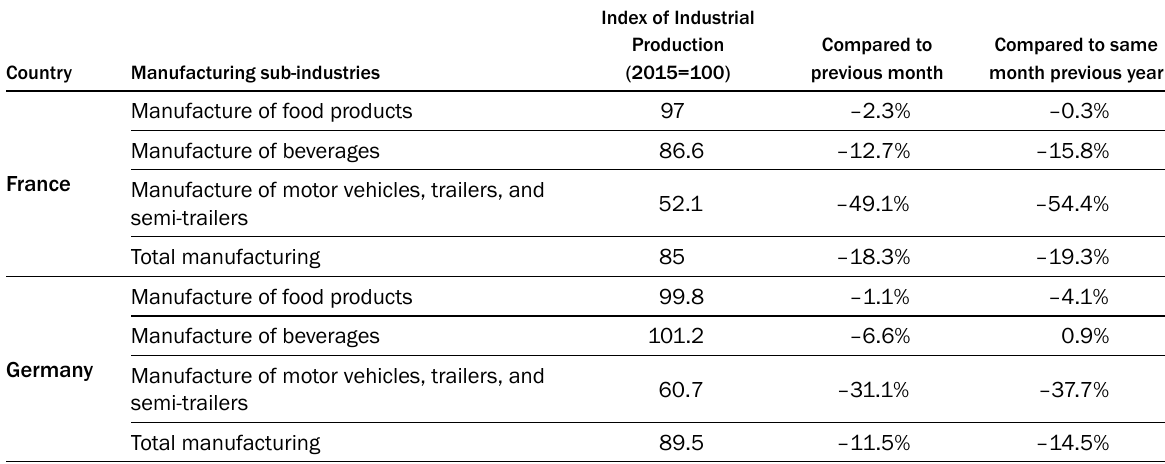
Table 1. Manufacturing Production in France and Germany, March 2020